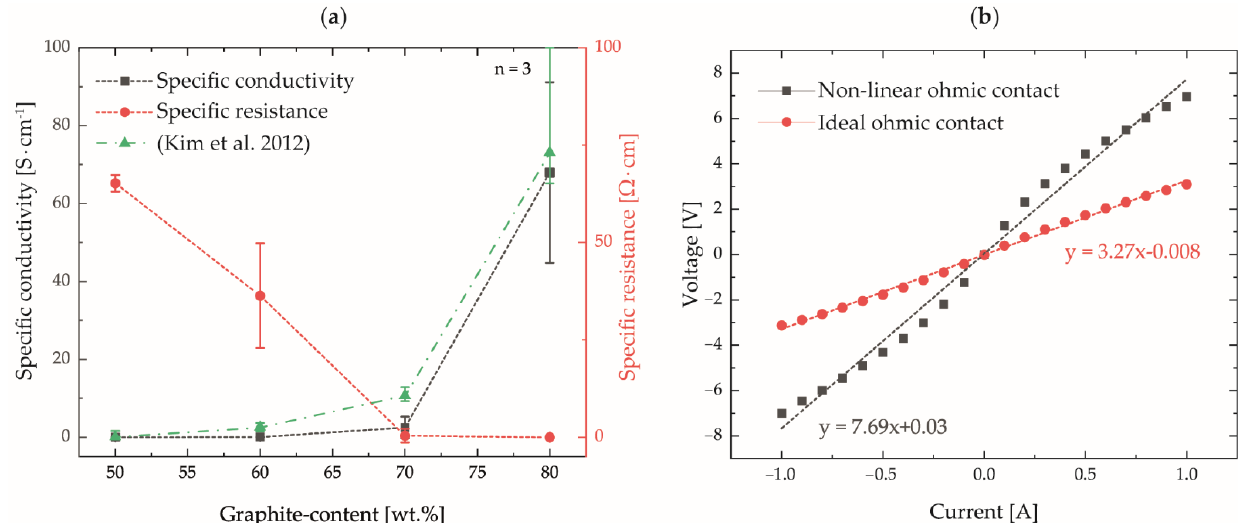
Figure 8. ( a ) Determined specific resistance and specific conductivities of the compounds produced in comparison with literature values [16]; ( b ) visualization of ideal and non-ideal contacting based on exemplary voltage–current